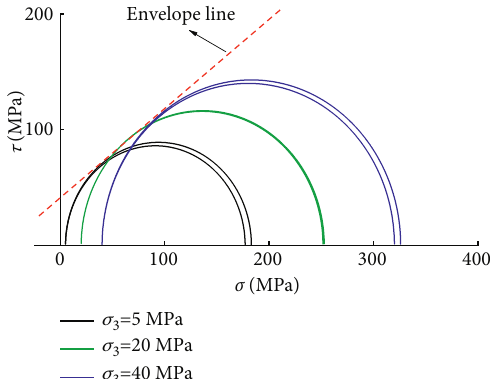
Figure 13: Mohr circles and failure envelopes of intact samples under different confining pressures.